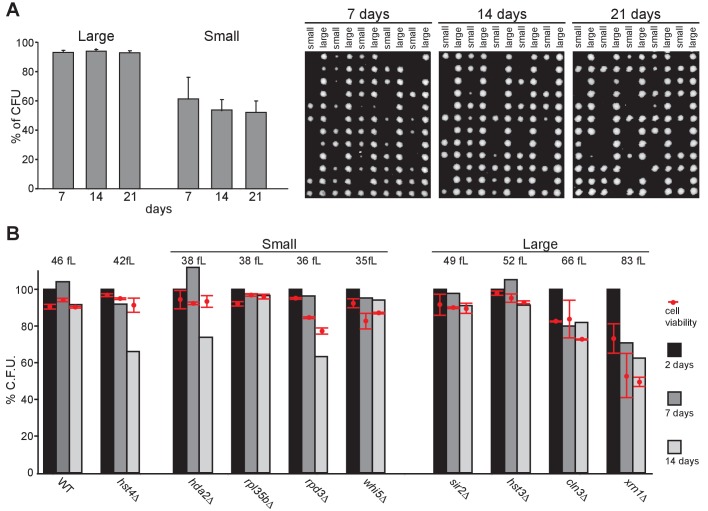
Cell viability and quiescence exit capacity after proliferation cessation in function of cell volume.(A) WT prototroph cells grown for the indicated time in YPD were individually separated by micro-manipulation onto YPD plates according to their volume (n = 120, N = 2). Representative images of the plates after 3 d at 30°C are shown. (B) Percentage of viable cells (red dot) and colony forming units (CFU) of WT and mutants after 2, 7 and 14 d of growth in YPD. The colony numbers obtained after 2 d were used for normalization. Median cell volume in proliferation and SD are indicated.10.7554/eLife.35685.012Figure 3—figure supplement 1—source data 1.Cell category scoring for each replicated experiment in Figure 3—figure supplement 1 panel A and B.